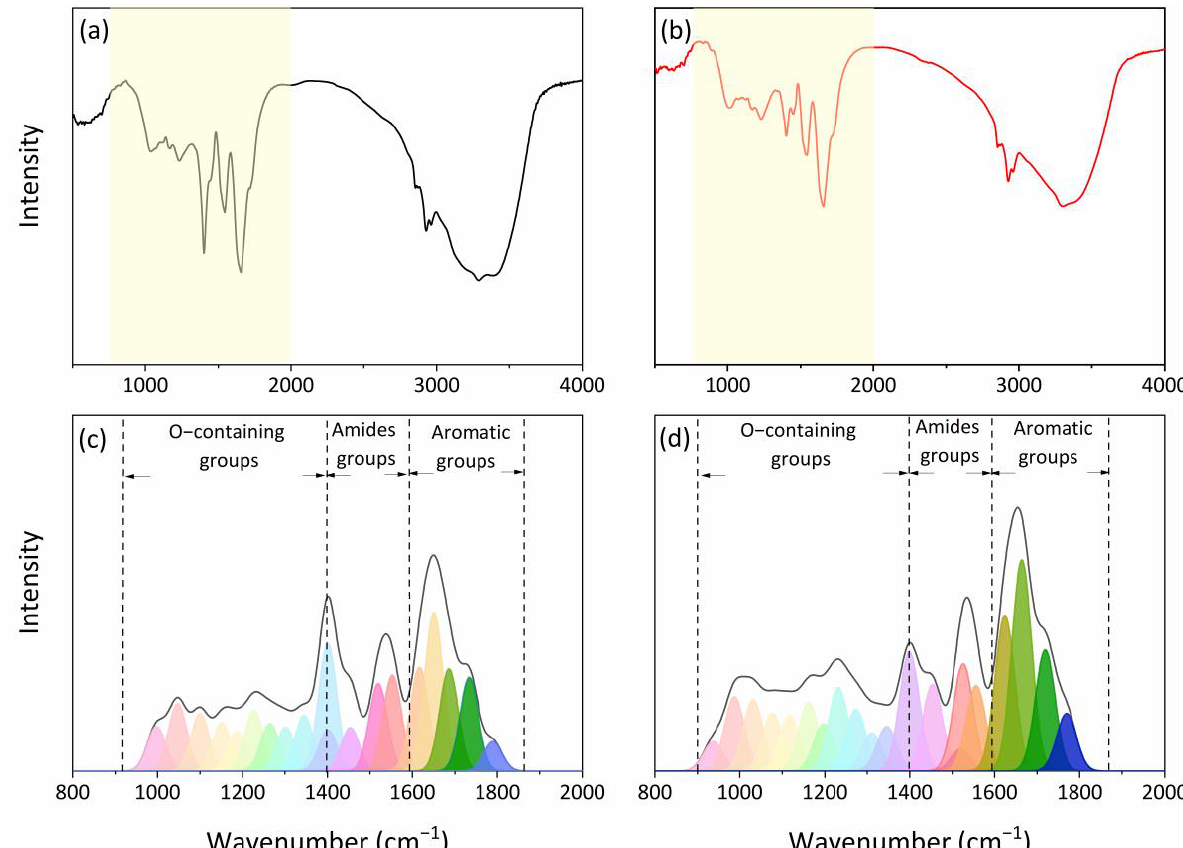
Figure 2. Normalized FTIR spectra of ( a ) humic acid, ( b ) struvite – humic acid composite, ( c ) the relative proportion of main functional groups in humic acid, and ( d ) struvite – humic acid composite.